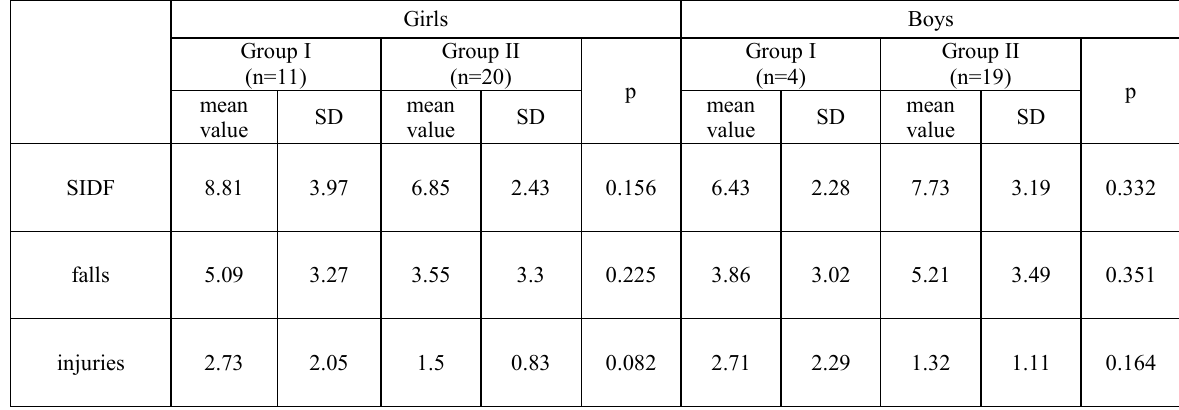
SIDF indicator value, the number of falls and injuries among the children aged 10-13 years Girls